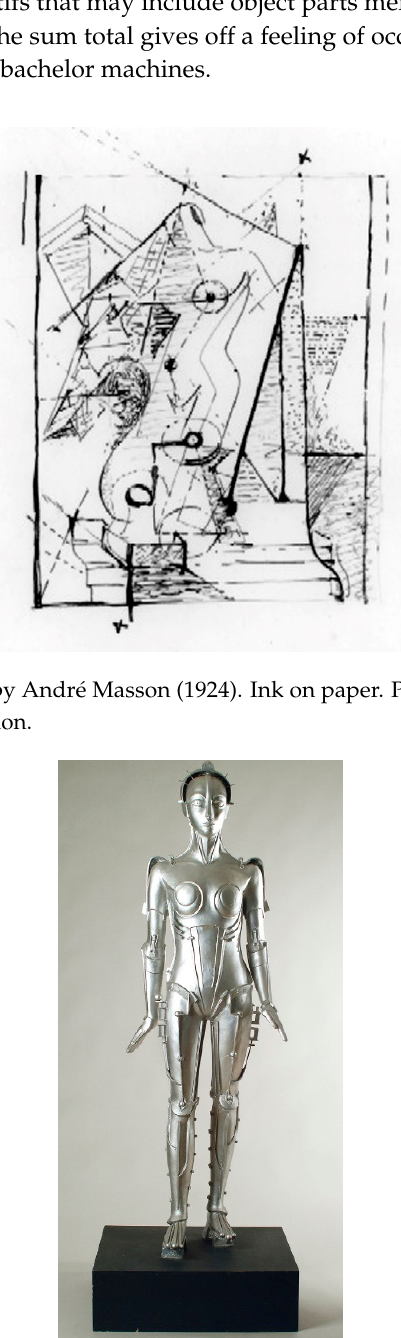
Figure 8 . Robot by Walter Schulze-Mittendorff from Fritz Lang’s film Metropolis , 1927. Copy created by the Louvre in 1994, painted resin, 190 cm × 74 cm × 59 cm. Cinémathèque française and used by permission.